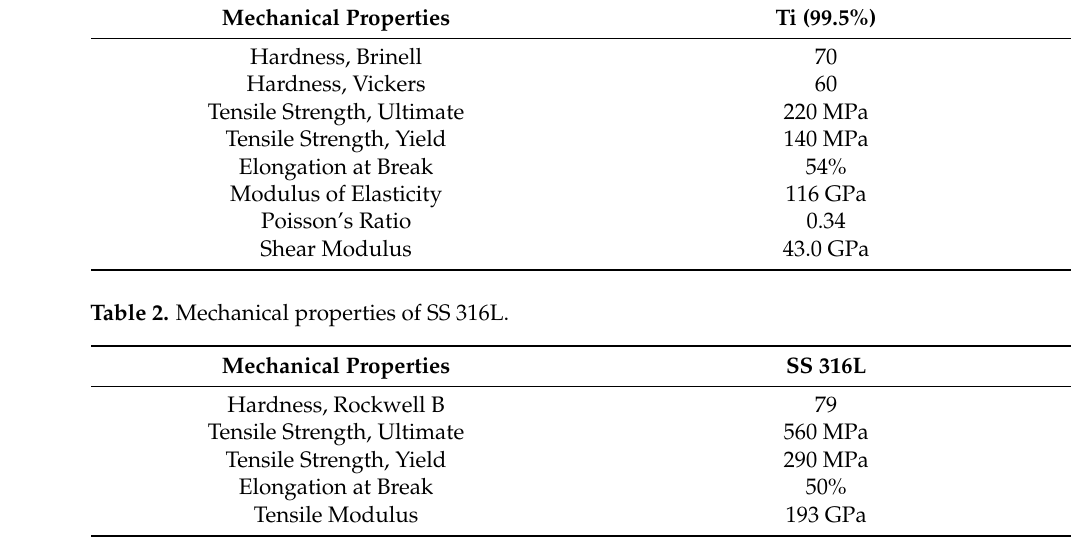
Table 3. Chemical properties of SS